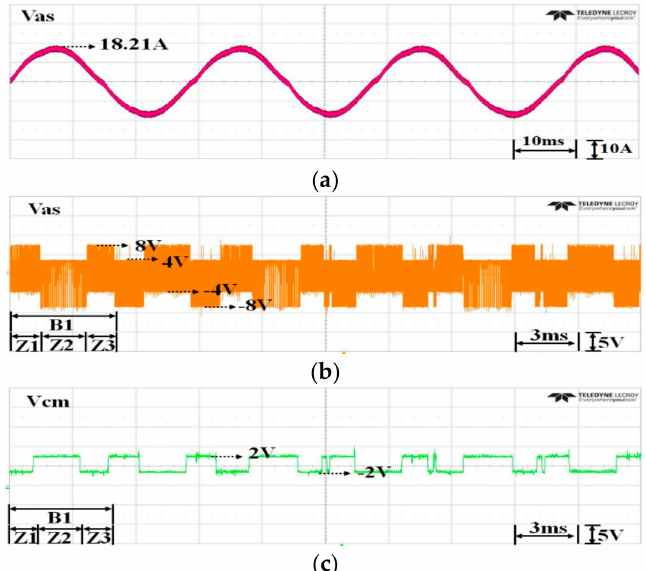
Figure 11. Experimental waveforms corresponding to the MTR-RSPWM: ( a ) phase current; ( b ) phase voltage; ( c )